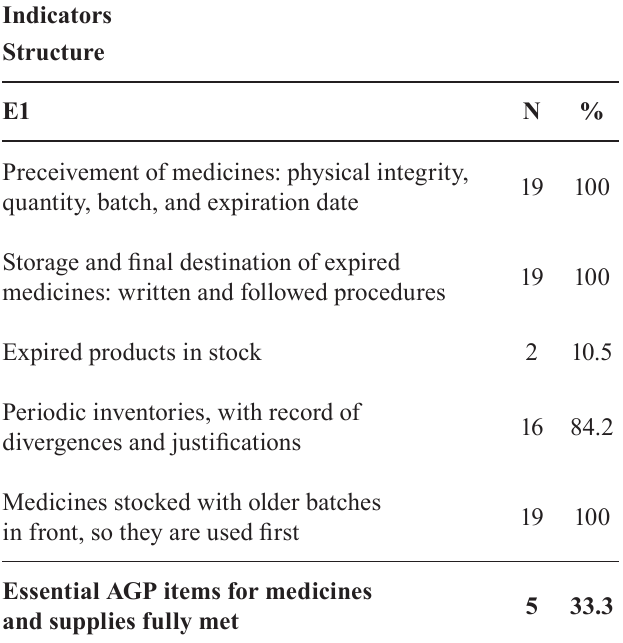
TABLE I - S tructure indicators (E1, E2 and E3) of PS in PHC, in 2015 and 2016.